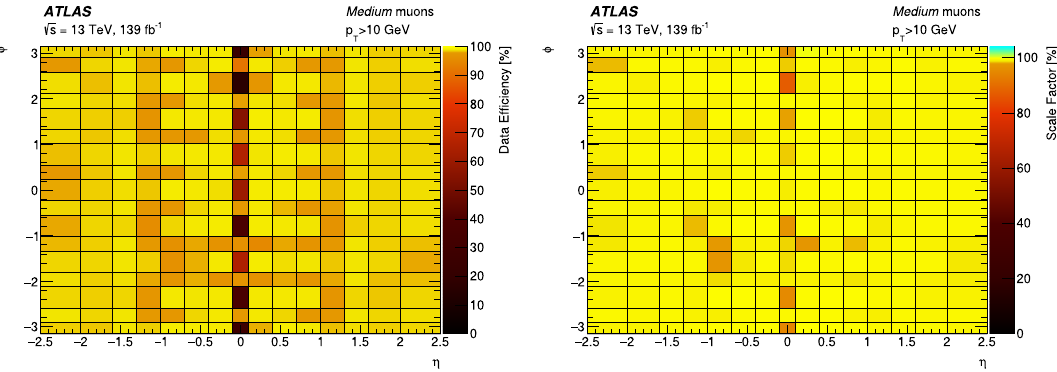
Fig. 14 Reconstruction and identification efficiency measured in collision data (left), and the data/MC efficiency scale factor (right) for Medium muons as a function of η and φ for muons with p T > 10 GeV in Z → μμ